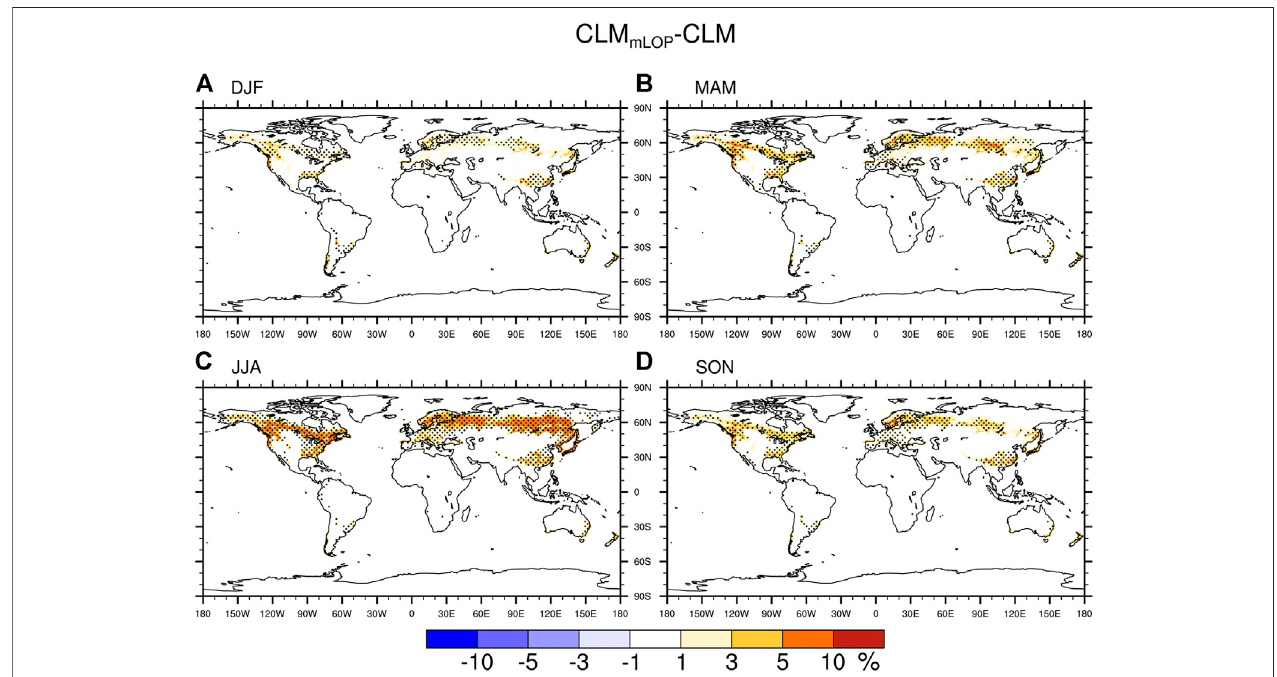
FIGURE 3 | Differences in mean seasonal albedo between CLM and CLM mLOP (black spots indicate signi fi cant differences greater than 95%).